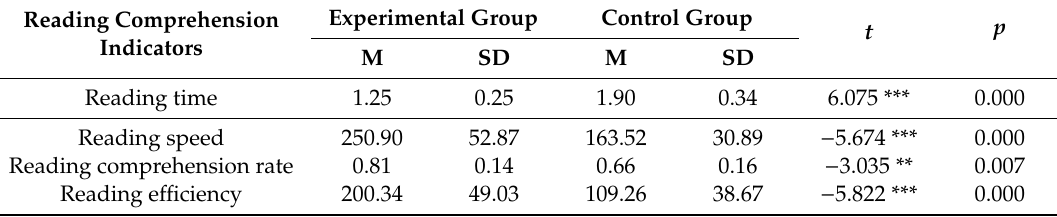
Table 5. The t -test results of reading comprehension indicators for the two